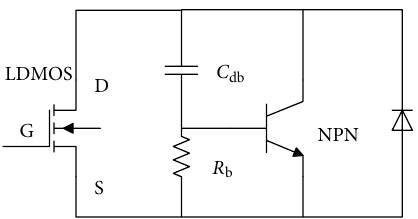
Figure 3: Electric scheme of LDMOS with parasitic NPN